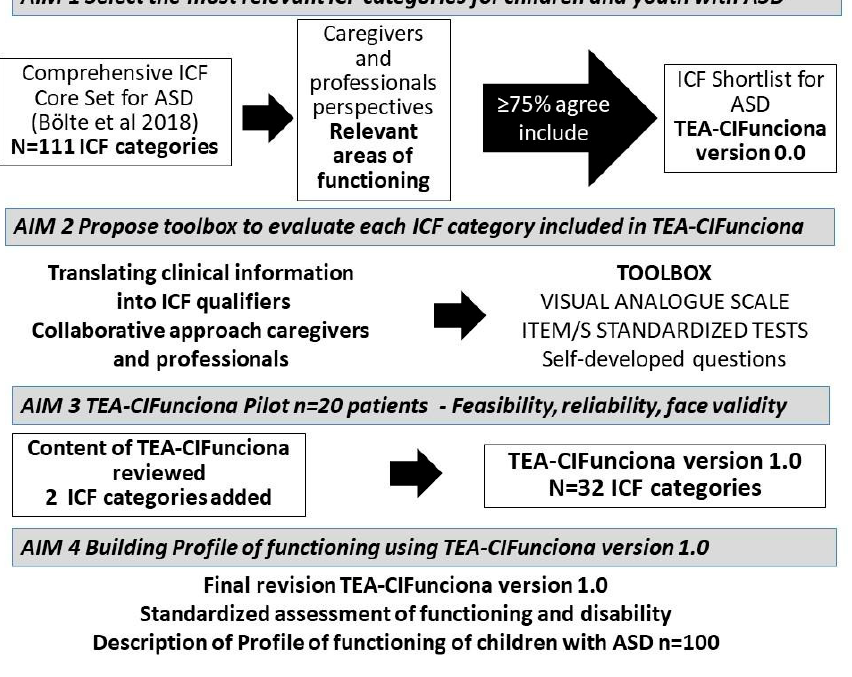
Figure 1. Multistep process for the development of TEA-CIFunciona and its clinical application.